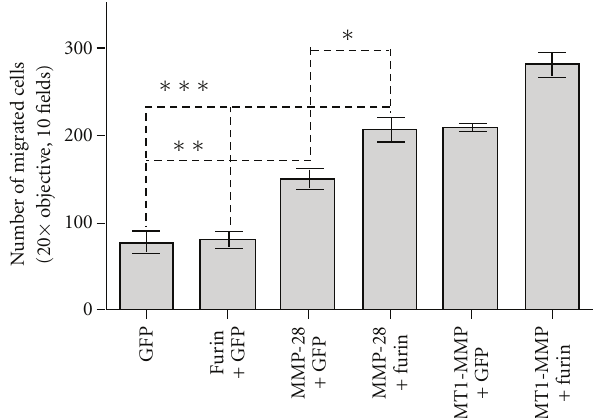
Figure 6: Increased MMP-28 secretion is accompanied with cell migration. The data show that furin enhances cell migration in MMP-28 transfected COS-1 cells. This enhancement is accom- panied by elevated MMP-28 tra ffi cking in the secretory pathway. COS-1 cells transfected with cDNAs as indicated were examined by transwell migration assay. Each sample was examined as triplicates and repeated three times. Each bar represents the mean ± SE. ( ∗ P = . 022; ∗∗ P = . 0058; and ∗∗∗ P = .